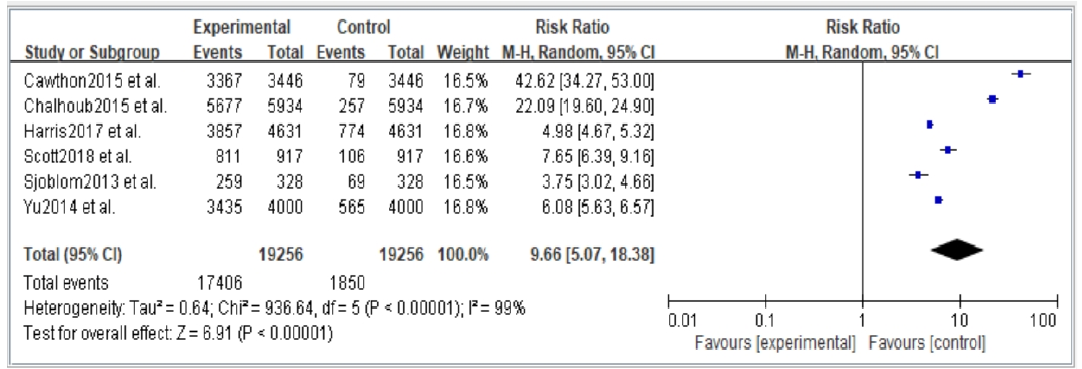
Figure 2. Summary estimates for the sarcopenia status compared to fall outcome.